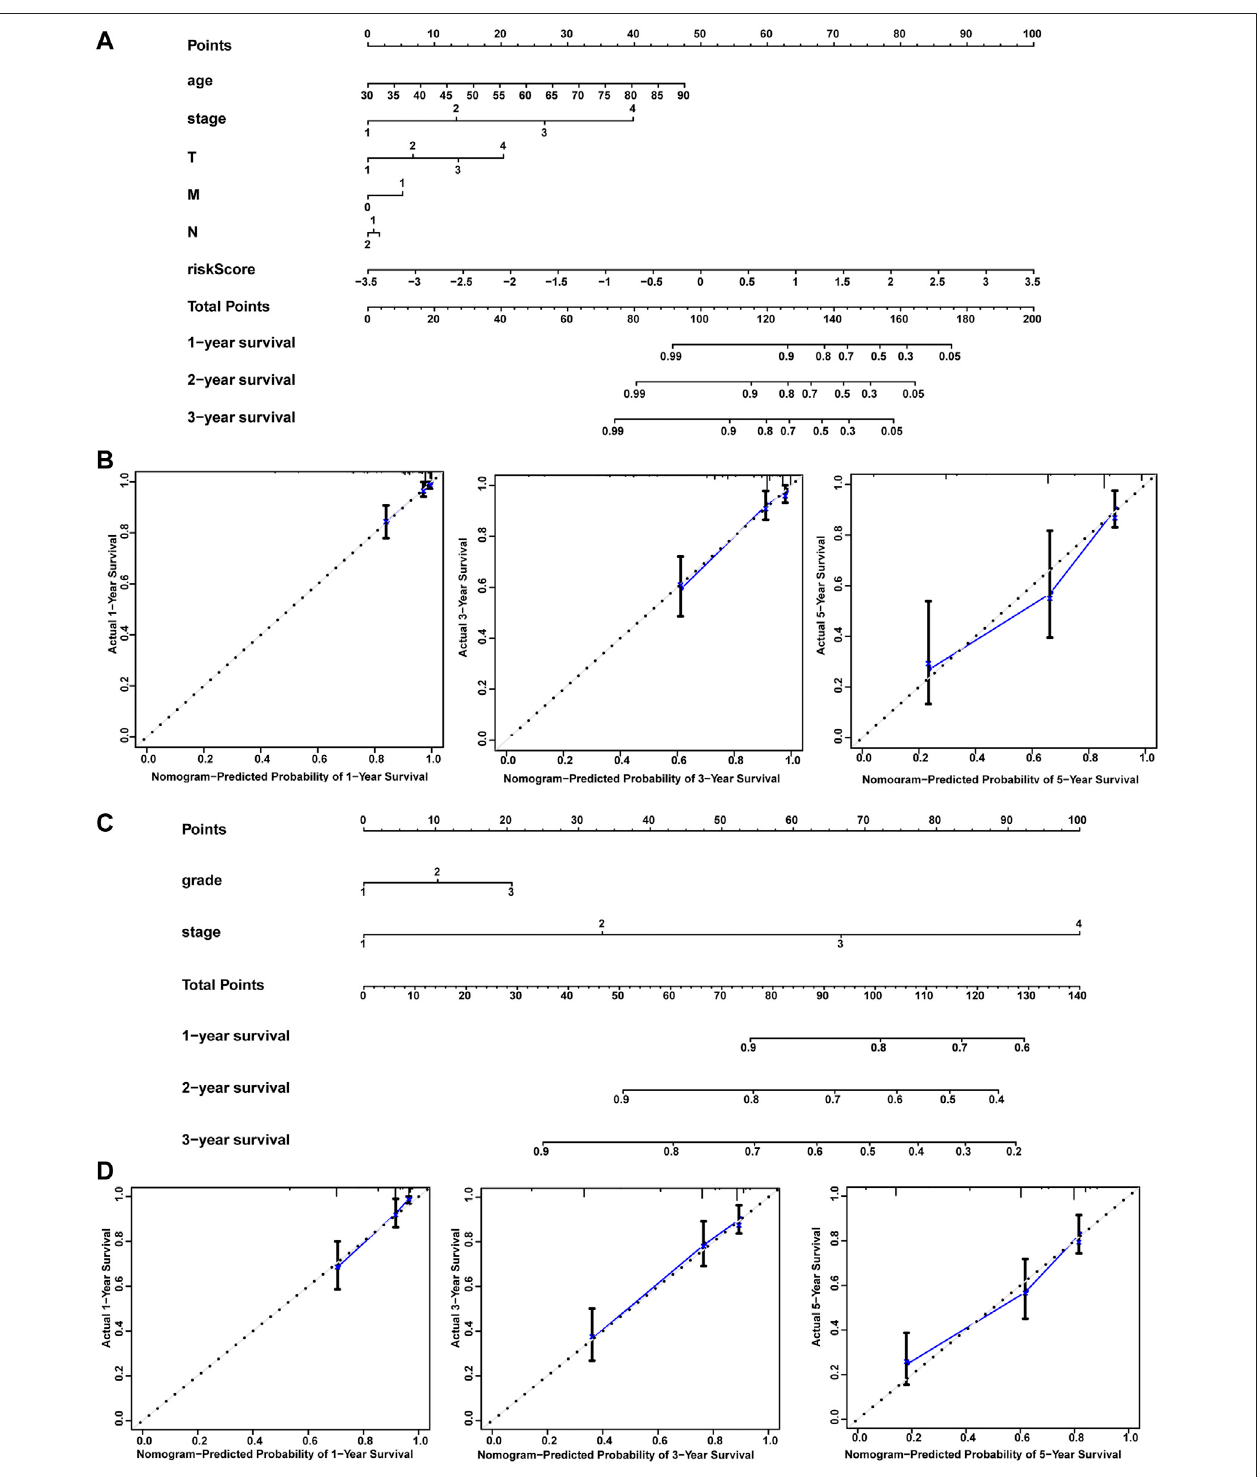
FIGURE 3 | Nomograms and calibration plots. Nomogram (A – C) and calibration plots (B – D) for predicting OS at 1 year, 3 years, and 5 years for CRC patients in the training and test cohorts.